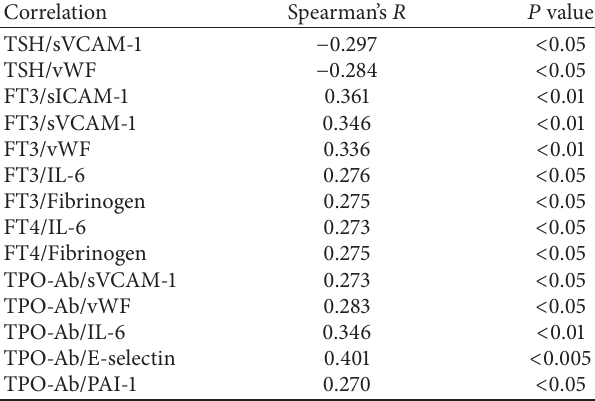
Table 4: Spearman’s rank correlation coefficients in the group with overt hyperthyroidism.